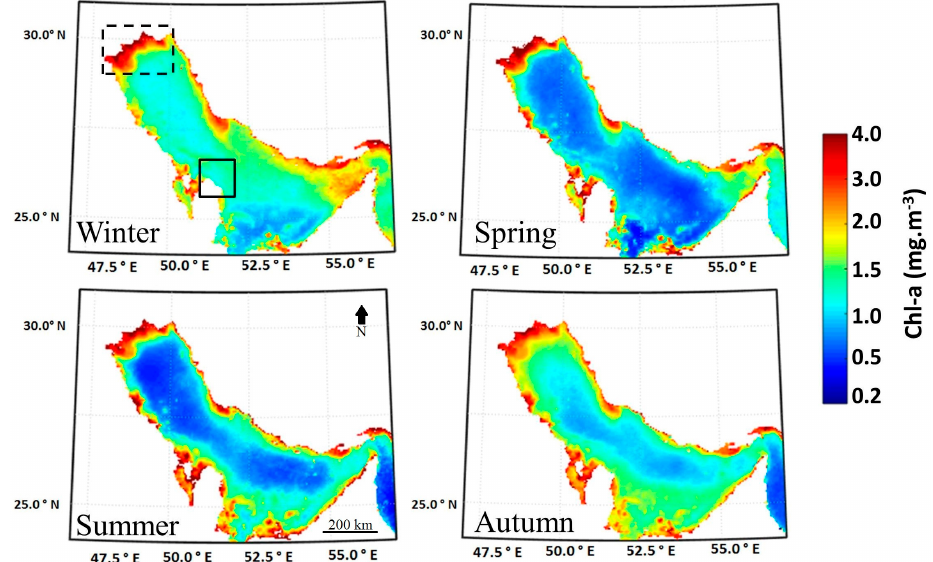
Figure 2. Seasonal climatologies of surface Chl -a (mg·m − 3 ) in the Arabian Gulf, based on satellite-derived Ocean Colour Climate Change Initiative (OC-CCI) datasets. The depicted climatologies data are calculated based on 16 years of data (1997–2013). The dashed-line box indicates the Shatt Al-Arab zone, and the solid-line box indicates the study area where the in situ samples were collected.